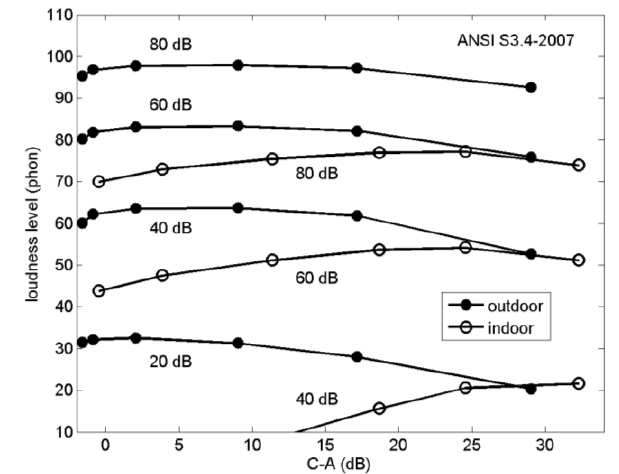
Figure 10. Loudness level as a function of C–A calculated with ANSI S3.4-2007 for the spectra shown in Figures 8a and 8b, for outdoor A-weighted sound levels of 20, 40, 60, and 80